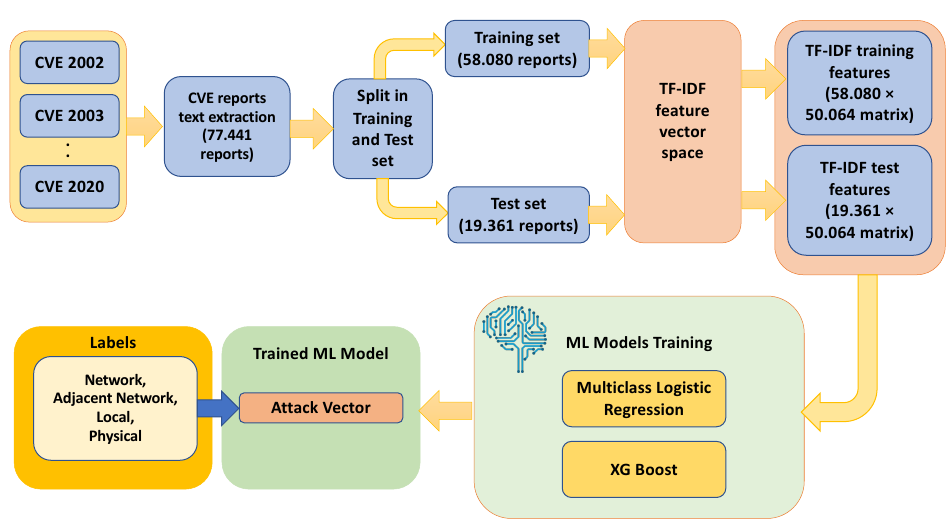
Figure 4. Flow diagram of the proposed supervised text-based machine leaning pipeline for the attack